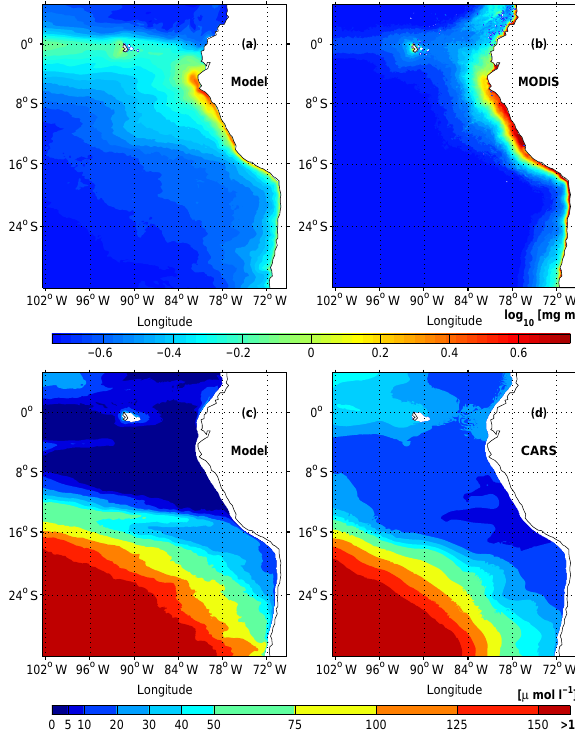
Figure 2. Sea surface chlorophyll concentration (in log 10 , mgm − 3 ) corresponding to (a) model simulation and (b) MODIS observation. Oxygen concentration at 300 m depth (µmolL − 1 ) corresponding to (c) model simulation and (d) CARS